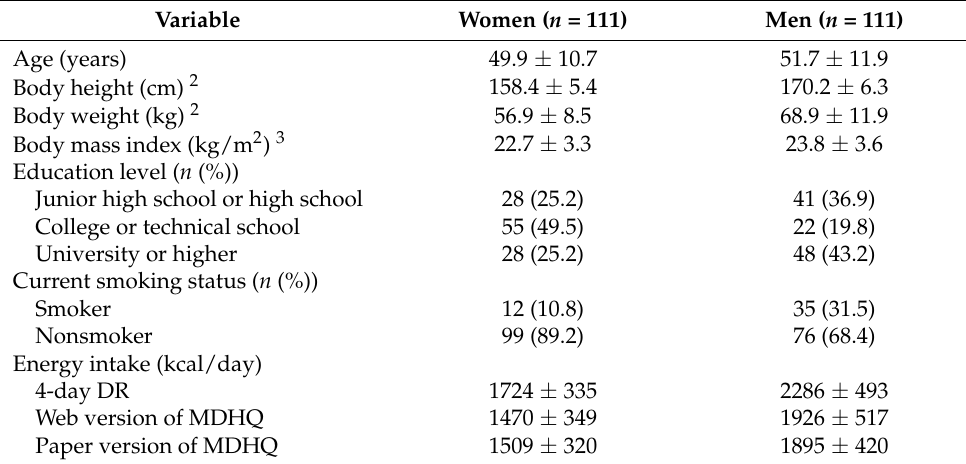
Table 1. Basic characteristics of the study subjects 1